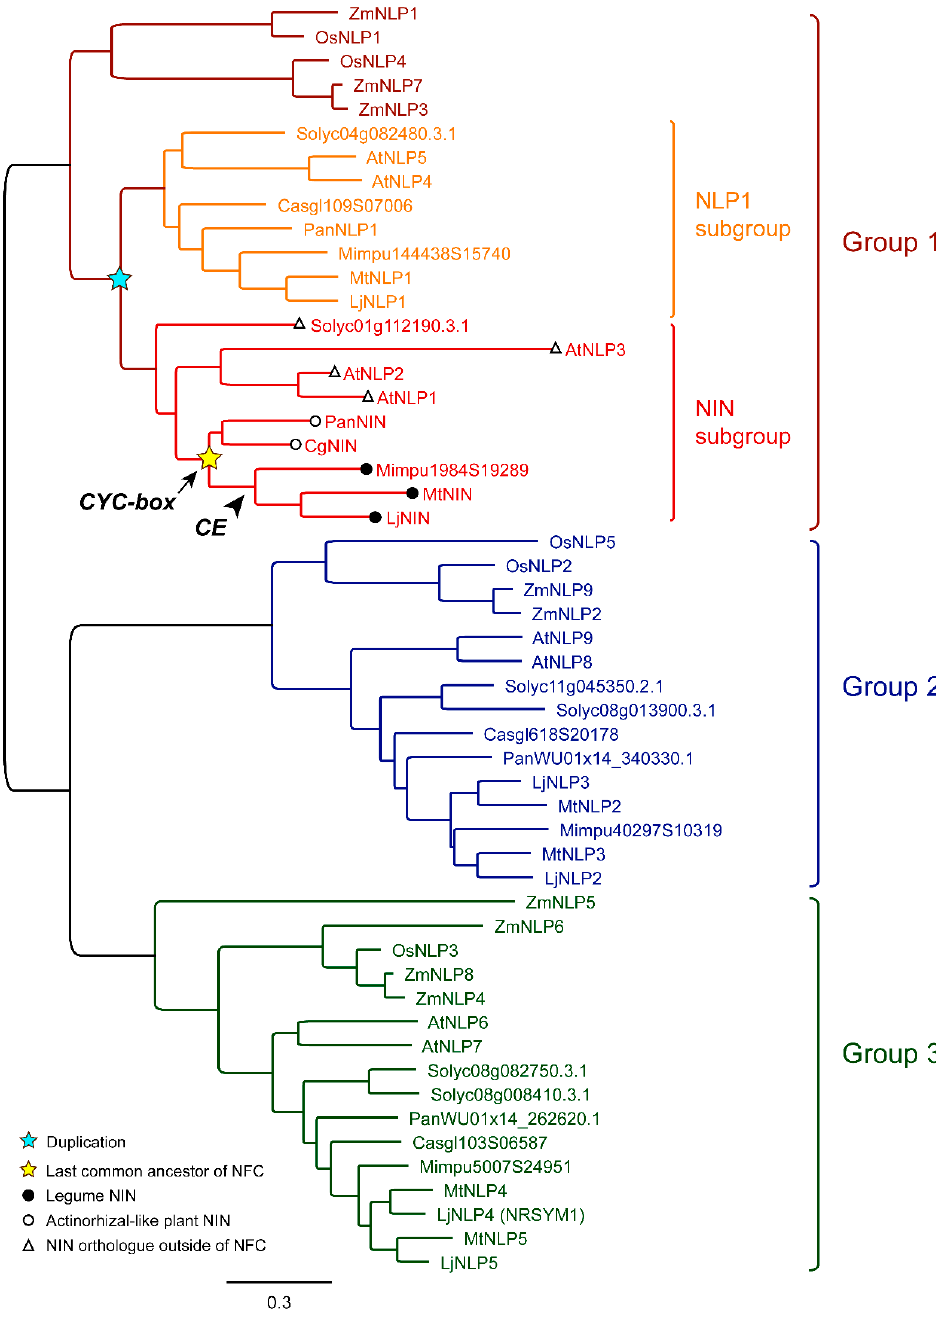
Figure 1. Phylogenetic tree of NIN and NLPs. The tree comprises 53 NIN / NLPs from Zea mays (Zm), Oryza sativa (Os), Solanum lycopersicum (Solyc), Arabidopsis thaliana (At), Casuarina glauca (Casgl / Cg), Parasponia andersonii (Pan), Mimosa pudica (Mimpu) Medicago truncatula (Mt) and Lotus japonicus (Lj). These NIN / NLPs are divided into three orthogroups as indicated. Dicots of Group 1 most likely undergo duplication (blue star), which generates NIN and NLP1 subgroups. The NIN subgroup comprises symbiotic NIN from NFC species (yellow star indicates the last common ancestor of NFC), including NIN of actinorhizal-like plant NIN (hollow circle) and legume NIN (filled circle), and putative NIN orthologues in non-nodulating species outside of NFC (hollow triangle). The CYCLOPs binding site ( CYC-box ) in the NIN promoter was likely gained by the ancestor of NFC (arrow), whereas cytokinin responsive elements (CE) in the NIN promoter specifically evolved in the legume branch (arrow head). Corresponding accession numbers and protein sequences are listed in the Supplementary Material S1.